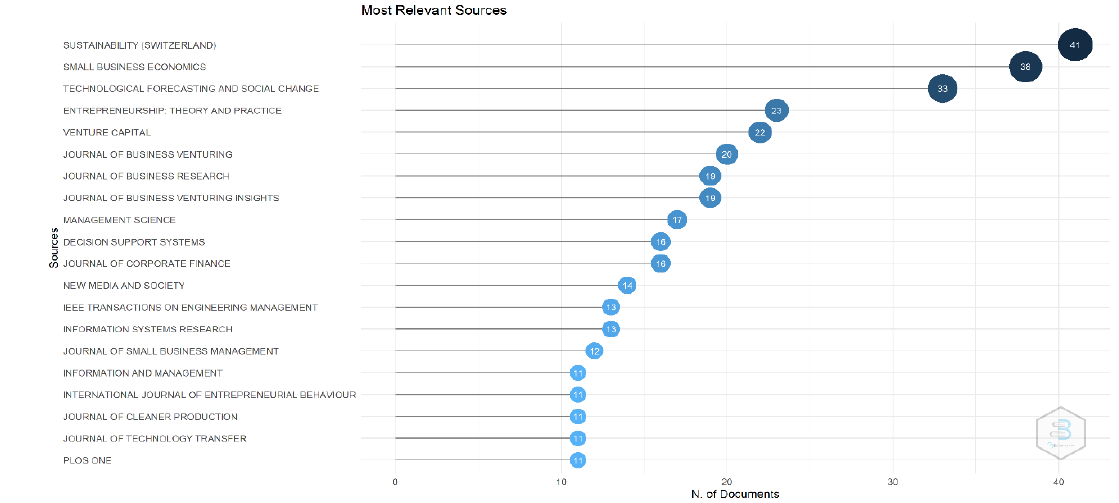
Figure 4. Most relevant sources (number of documents).